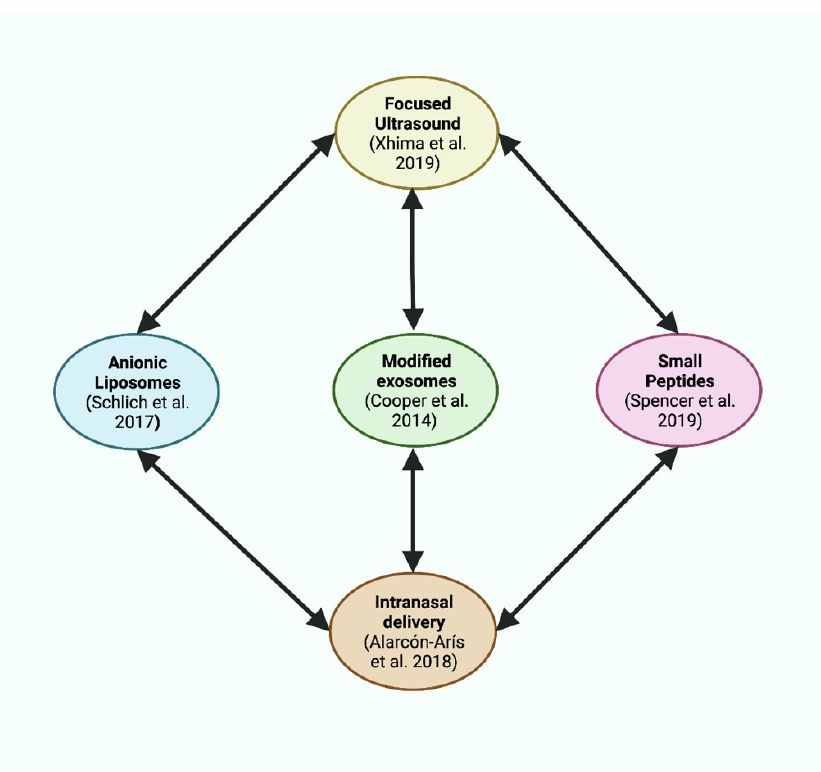
Figure 2. The varying novel strategies that could be utilized to improve RNAi BBB penetration. Each strategy is described in the main text, but it should be emphasized that the combination of some of these strategies (arrows) might be considered for further increasing treatment efficiency. This figure was created with BioRender.com.